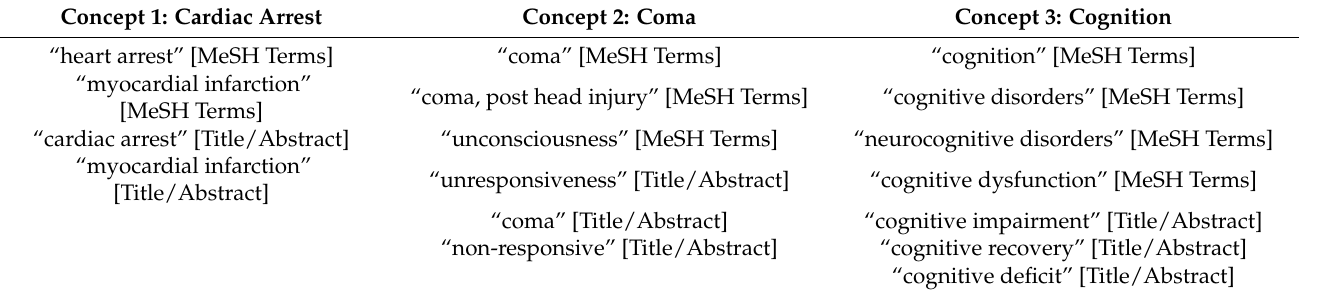
Table 2. Search strategy for cognitive outcomes of patients with a brain injury secondary to cardiac arrest (Concept 1) following a period of unconsciousness. All terms in the table were included in the search. Concepts are separated into columns where each term in the column was separated by “OR” in the search and concepts were separated by “AND”.